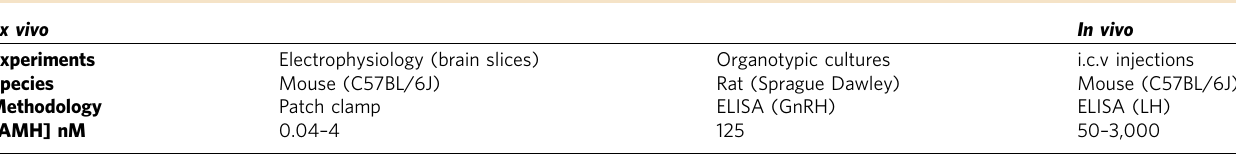
Table 2 | Doses of recombinant AMH used in ex vivo and in vivo